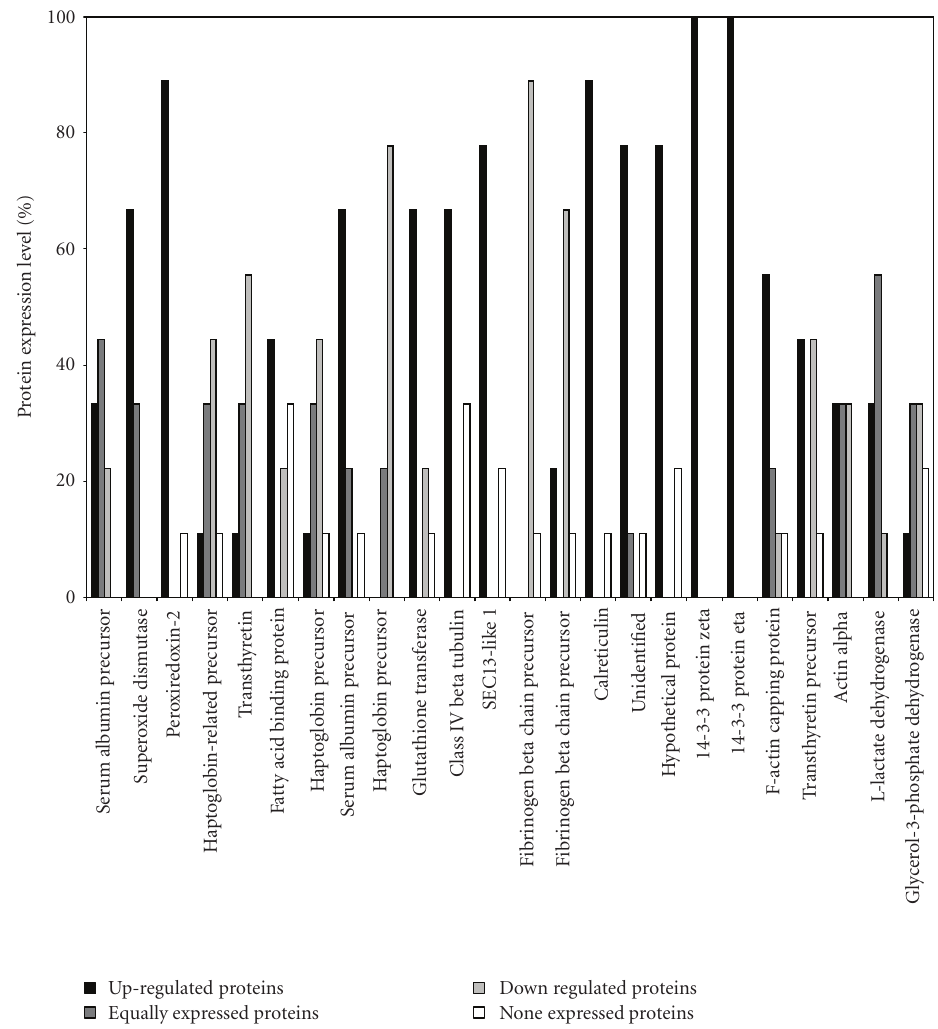
Figure 9: Distribution of proteins in Grade III